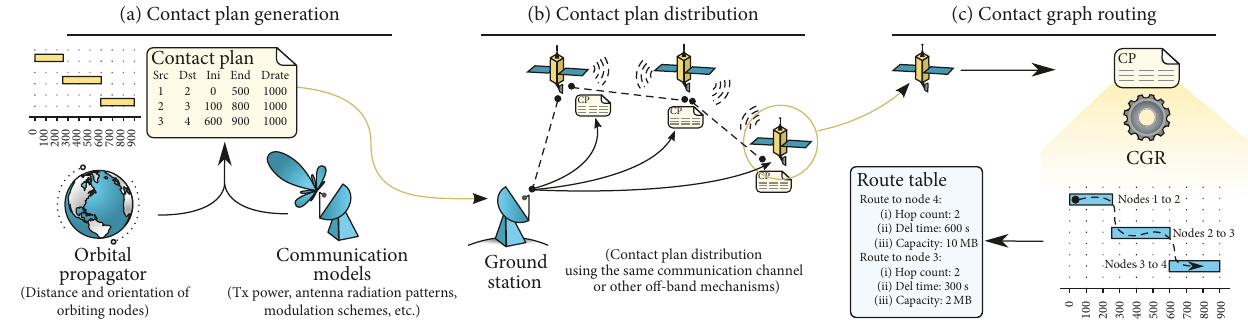
Figure 2: Contact plan generation, distribution, and utilization by